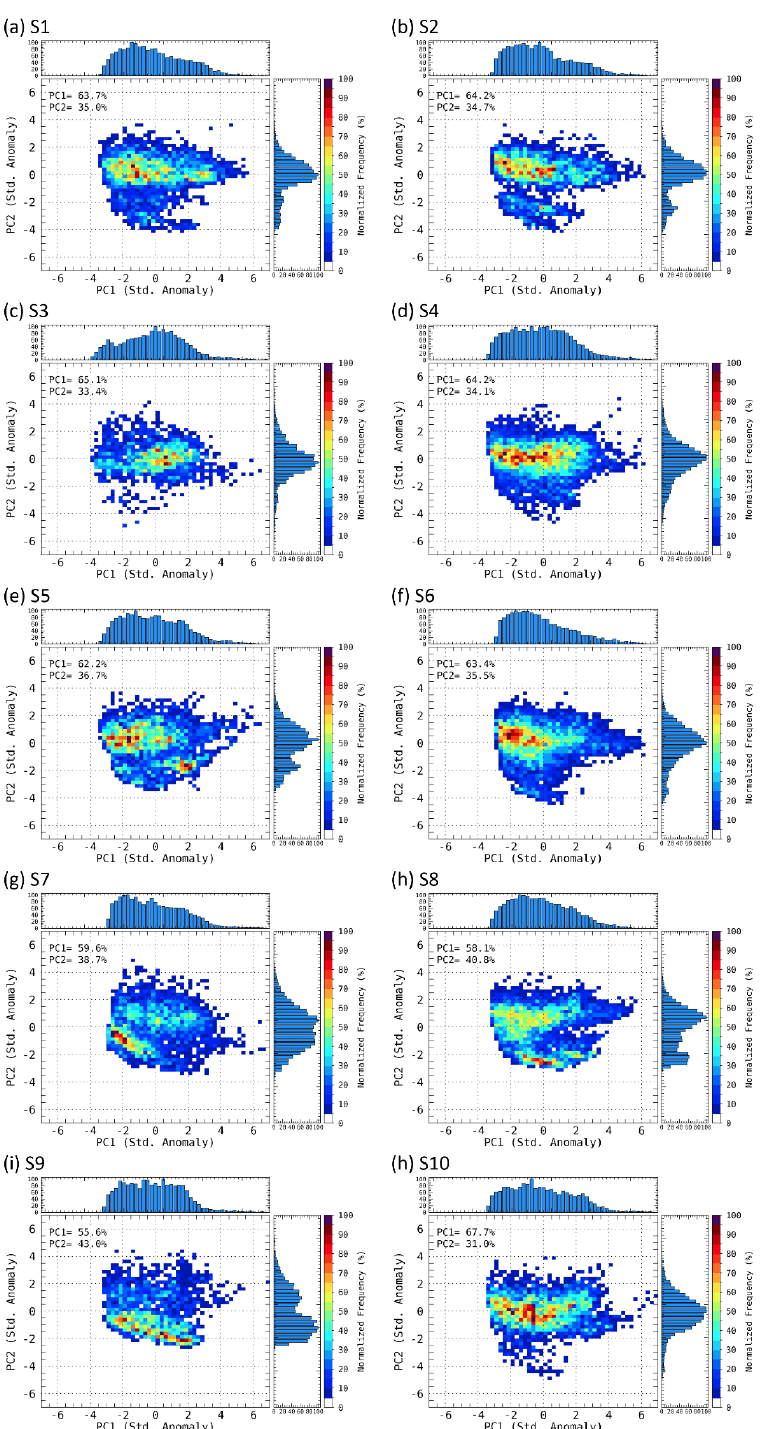
Figure 12. The normalized frequency density of the joint distribution of PC1 and PC2 for S1–S10 sites.